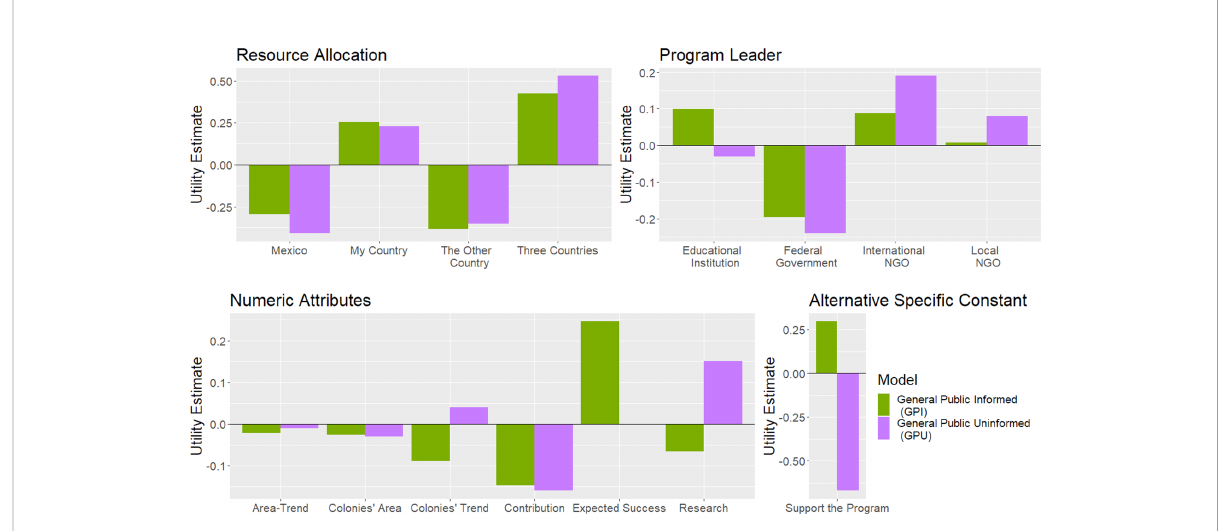
FIGURE 4 Utility estimates for the behaviour models of urban residents informed (GPI) and uninformed (GPU) about the likely success of a Monarch conservation strategy. The y-axis is a dimensionless representation of the utility derived from a speci fi c level of an attribute. The Alternative Speci fi c Constant (ASC) represents the willingness to support the program regardless of its con fi guration. Figure modi fi ed from (Solis-Sosa et al.,